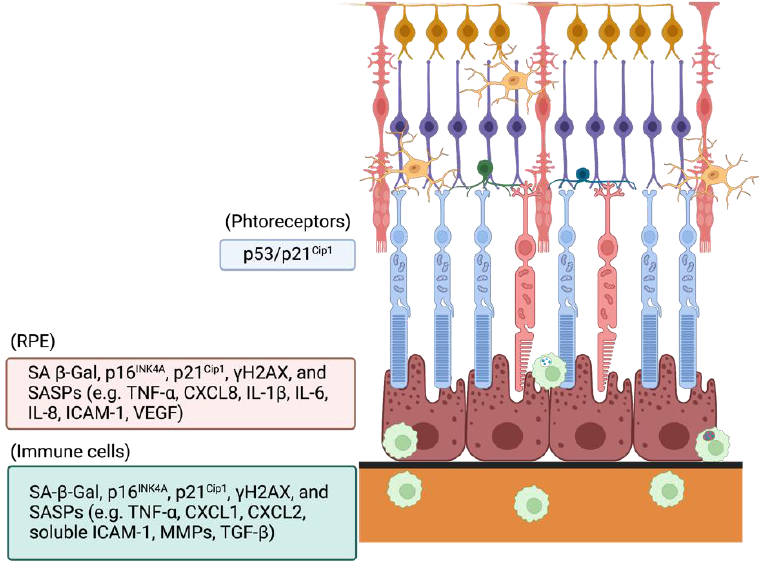
Figure 3. Oxidative stress-induced senescence markers associated with AMD in the retinal cells.